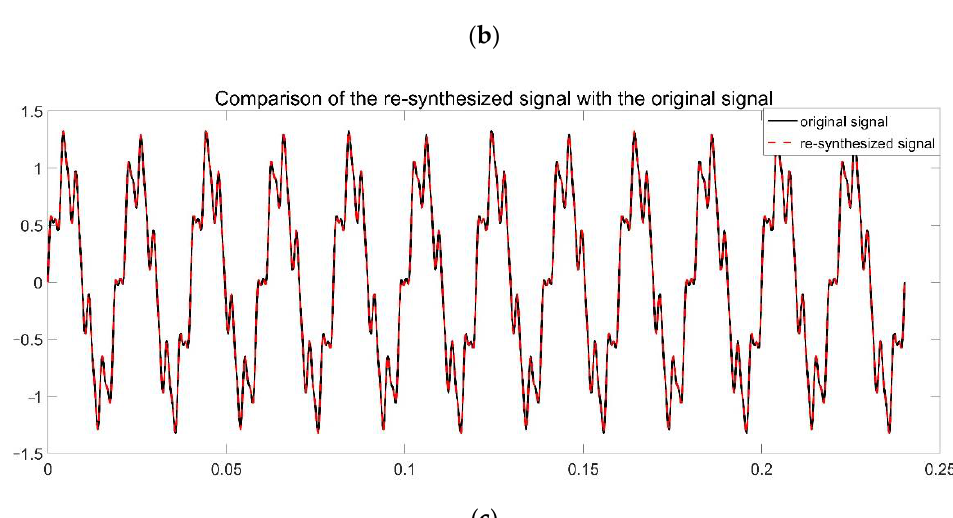
Figure 4. Decomposition result of LMD. ( a ) Original signal. ( b ) PF component. ( c ) Comparison of the resynthesized signal with the original signal.